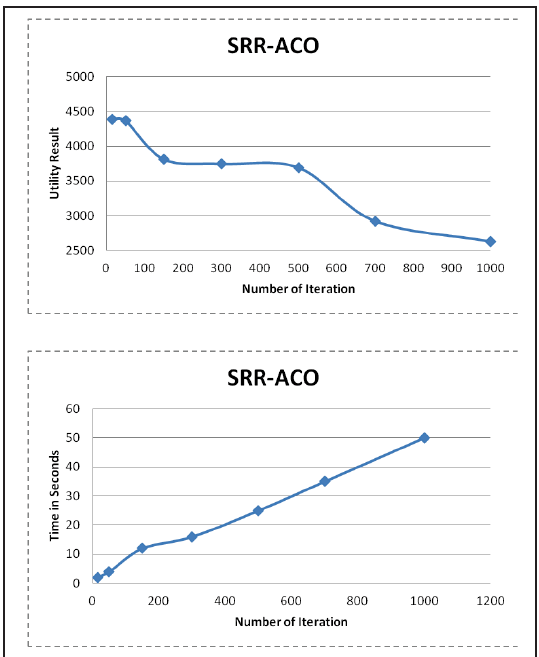
Figure 3: Time and utility related to number of